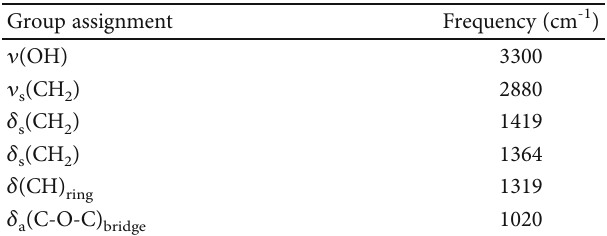
Table 1: FTIR assignments of